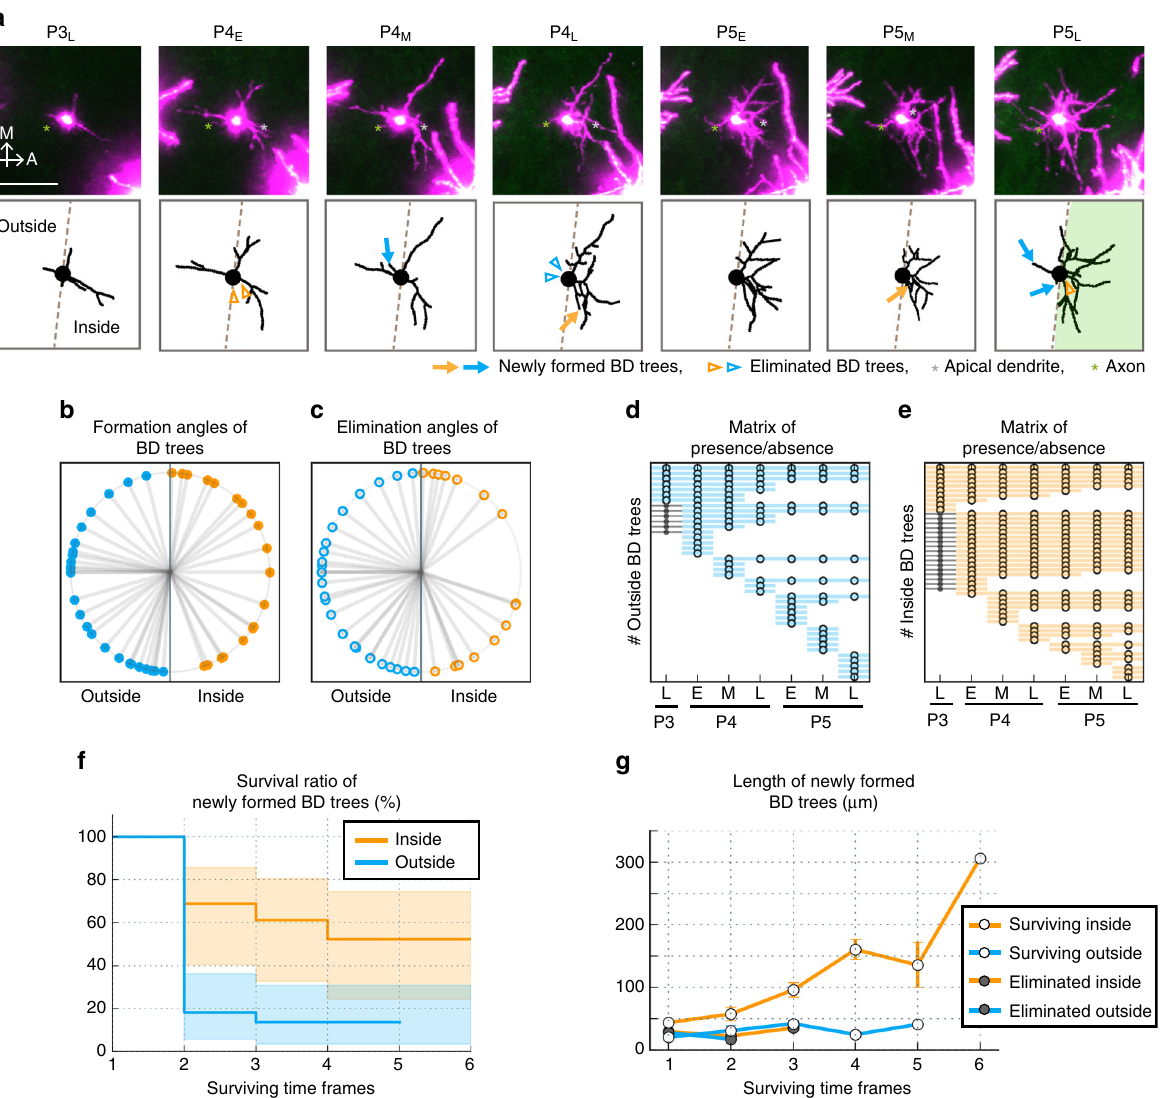
Fig. 4 BD tree dynamics of SS neurons with 8-h intervals. a (Top) Z-stack images of a representative eSS neuron from P3 L to P5 L with 8-h interval. Gray asterisk, AD; green asterisk, axon. (Bottom) Traces of the neuron in upper panels. Arrows indicate newly formed inner (orange) and outer (blue) BD trees. Arrowheads indicate origin positions of eliminated inner (orange) and outer (blue) trees. Scale bar: 50 µ m. b , c Angles of origins of trees that were newly formed ( b ) and eliminated ( c ) between P3 L and P5 L . Vertical line and center indicate inside/outside border and cell body position, respectively. d , e Matrix of presence/absence of individual outer ( d ) and inner ( e ) trees. Each row represents an individual tree. Circles indicate time points at which the tree was present. Dots indicate time points at which the tree image was not acquired due to technical problems. Trees are sorted in order of the formation time and life span length. f The surviving ef fi ciency was signi fi cantly higher for inner trees than for outer trees ( p = 0.004, χ 2 = 8.282, Log-rank test). In these analyses, only BD trees that were newly formed during P3 L – P5 L are used. Shaded areas represent log – log transformed 95% con fi dence intervals. Sample sizes are shown in Supplementary Table 2. g Relationship between survival time frames and mean length ± SEM of individual trees that were